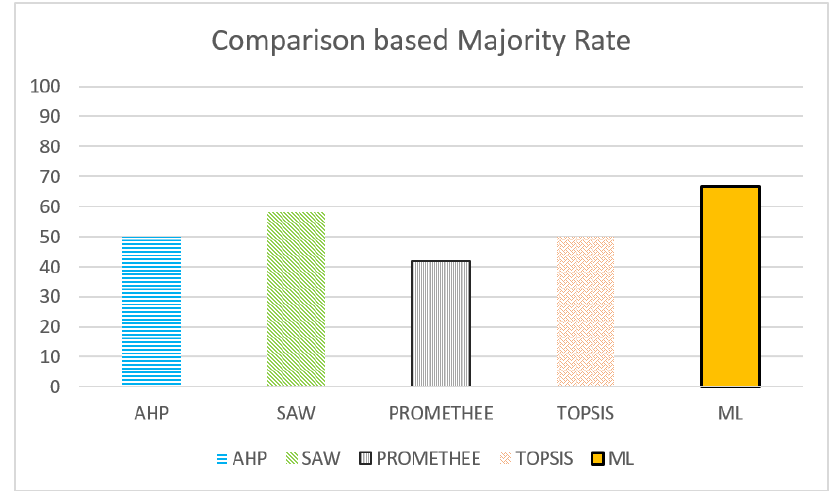
Figure 9. Comparison results of our ML approach against other MCDM models using the majority voting approach. The percentage value represents the agreement with the majority choice. AHP = analytical hierarchy process, SAW = simple additive weighting, PROMETHEE = preference ranking organization method for enrichment evaluation, TOPSIS = technique for order preference by similarity to ideal solution, ML = our ML-driven two-phase approach.